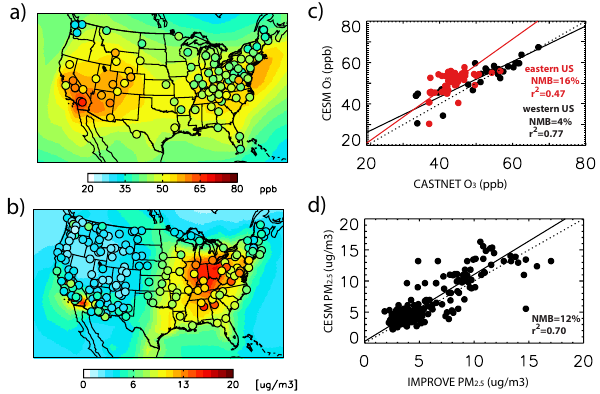
Figure 2. Simulated and observed present-day surface MDA-8 O 3 and PM 2 . 5 (a, b) and the scatter plots with modeled and observed values at the individual sites (c, d) . Observations are long-term means from the CASTNET (1995–2005) and IMPROVE (1998– 2010) networks. The squared-correlation coefficients ( r 2 ) and nor- malized mean biases (NMB) are shown in the inset. Reduced major- axis-regression lines (solid) and the 1:1 lines (dashed) are also shown. Maps show interpolated contours from the 1.9 × 2.5 ◦ hori- zontal resolution